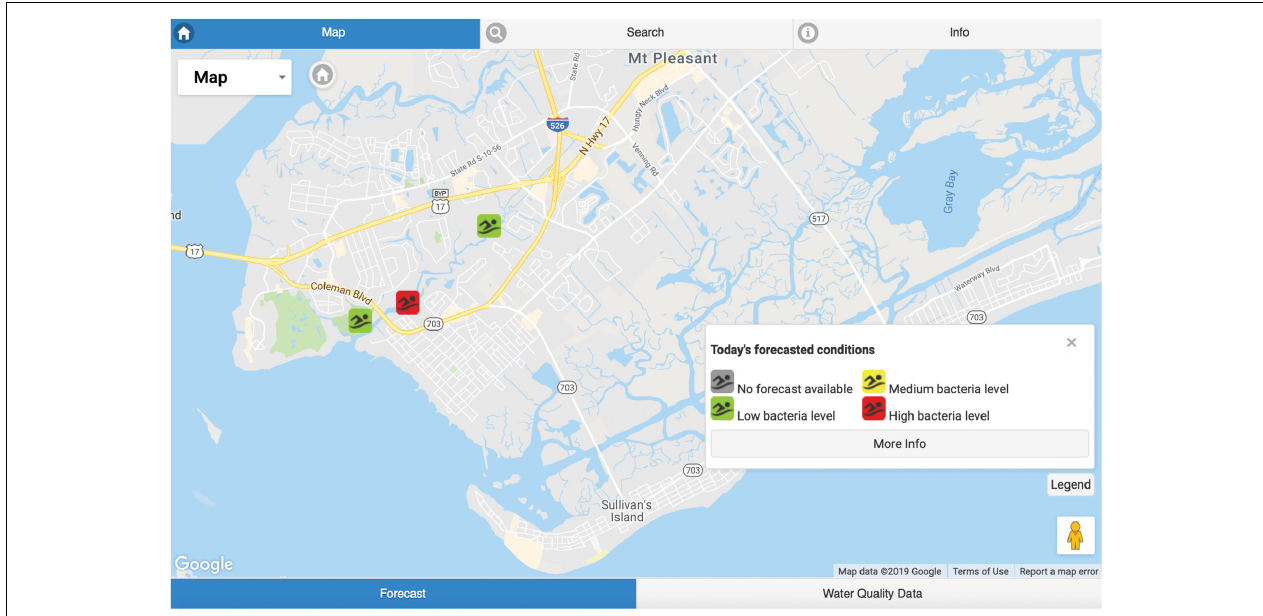
FIGURE 8 | Example display of How’s the Beach daily forecast of Enterococci bacteria levels for Shem Creek, SC. From here, users can view forecasts and access current and historical sampling data and high-resolution aerial imagery of specific sampling locations. Image courtesy of